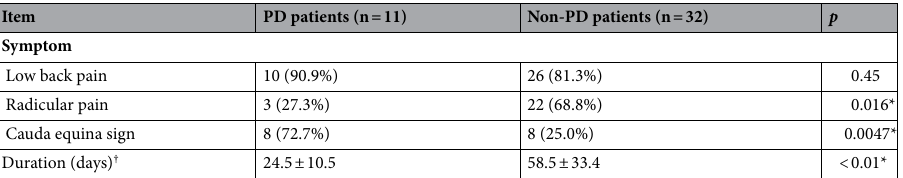
Table 2. Differences in clinical symptoms and duration in patients with and without Parkinson’s disease. † Duration from diagnosis of compression fracture to that of burst fracture and/or appearance of neurological symptoms. PD Parkinson disease. * p < 0.05.